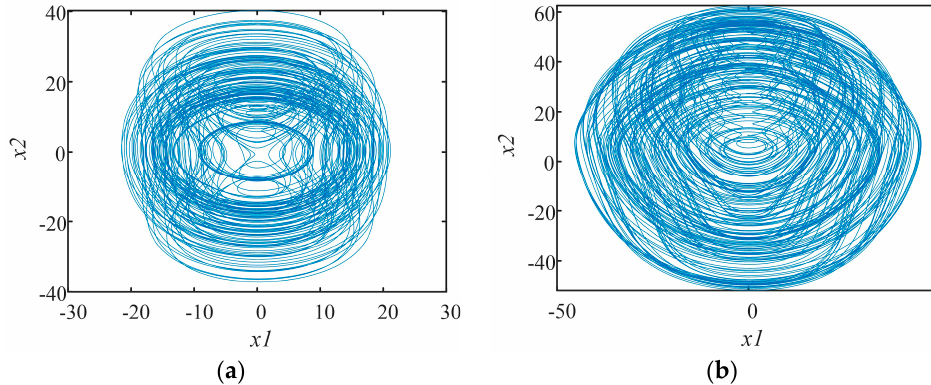
Figure 17. The phase diagram of attractor of DSP: ( a ) a = 2, b = 11, e = 1; ( b ) a = 0.3, b = 11, e = 7.